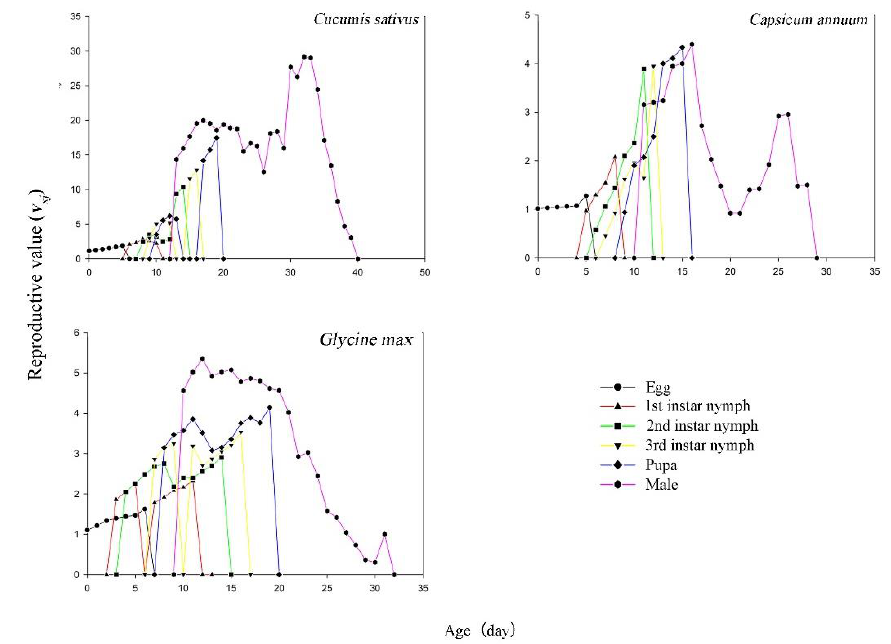
Figure 5. Reproductive value ( v xj ) of each age-stage group of Thrips flavus on different plants.